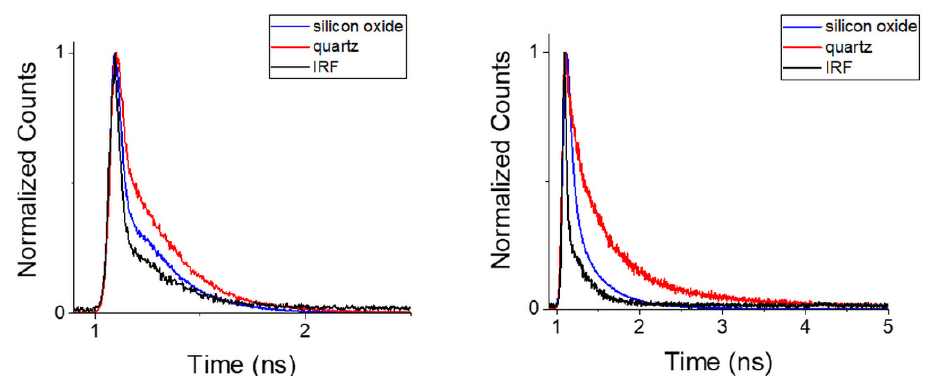
Figure 9. Photoluminescence decays collected for Poly(ProDOT)-Poly(MM) brushes grafted from quartz (red) and from silicon oxide (blue), together with the instrument response function (IRF, black). Left: decays monitored at blue region of emission band (λ < 492nm); right: those monitored at red region of emission band (595 nm < λ < 665 nm).